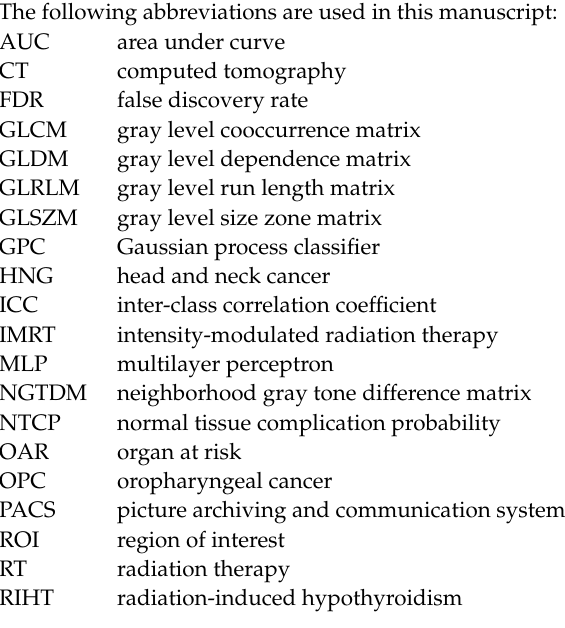
patients’ data, Table S2: Raw values of radiomic features, Table S3: Parameters of analyzed models’ architectures, Table S4: Stability of radiomic features, Table S5: Univariate analysis and filtration of radiomic features, Table S6: List of radiomic features selected after univariate analysis, Table S7: Quality metrics for all analyzed models, Table S8: Tripod checklist for our